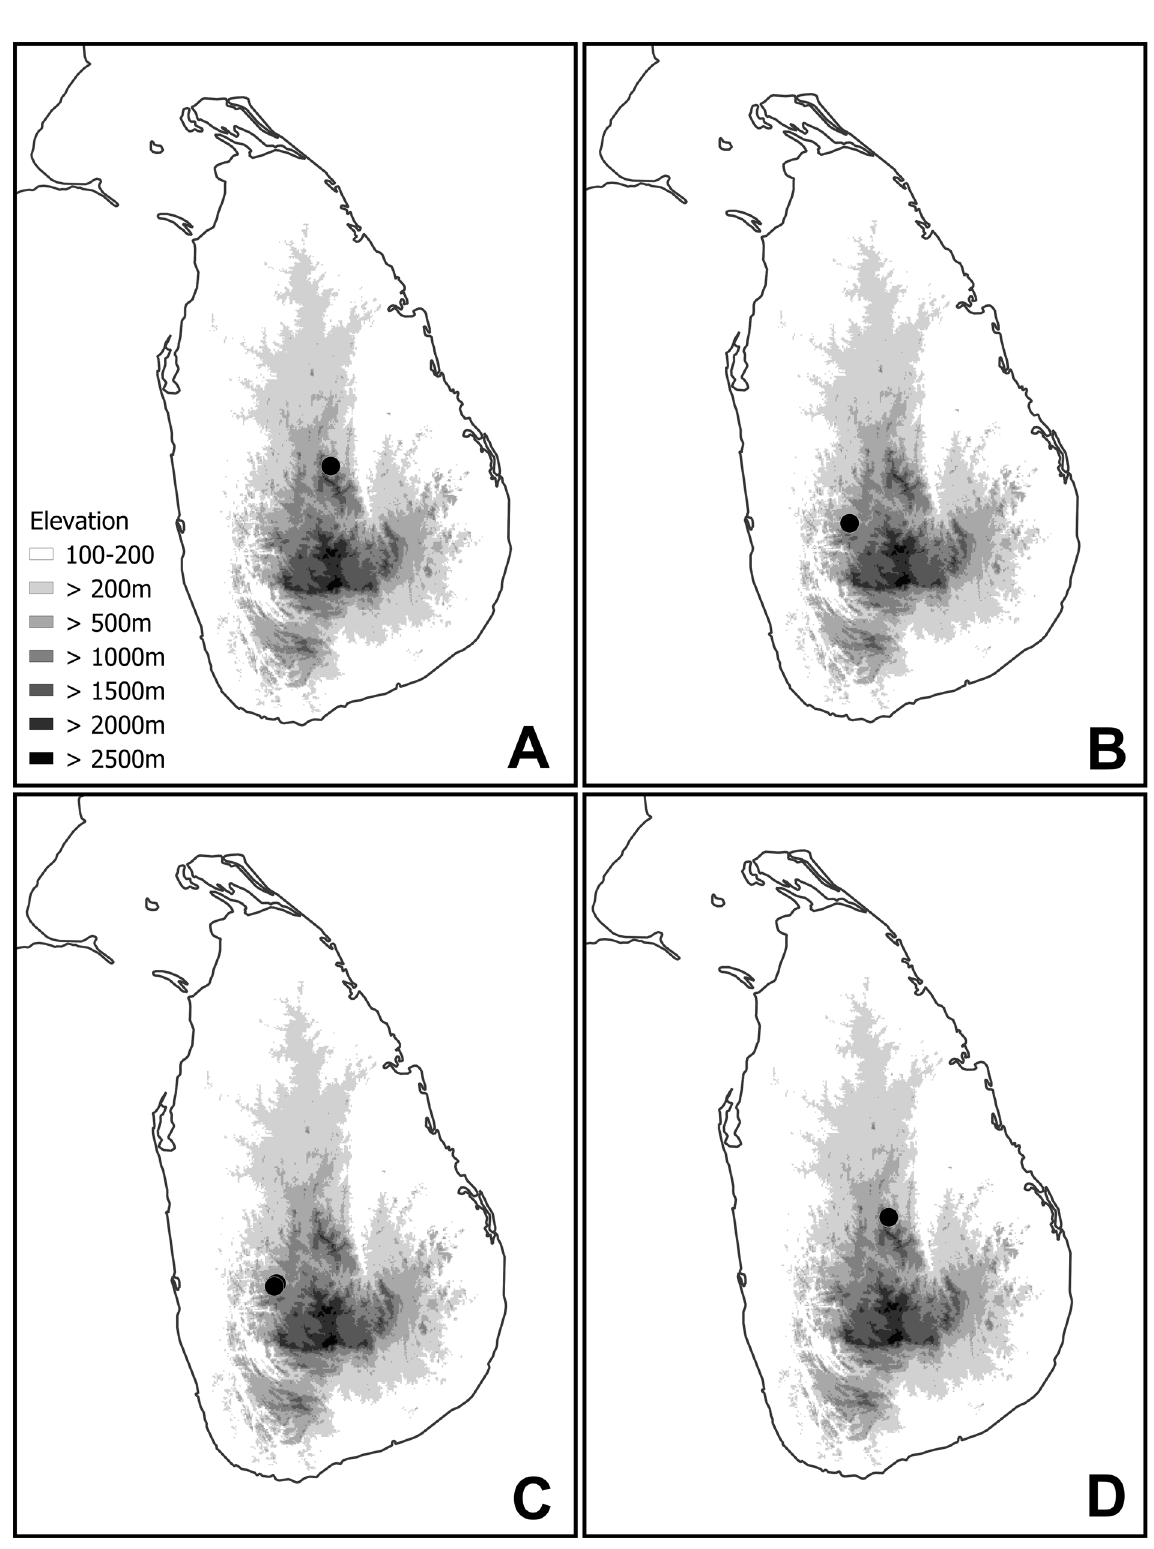
Fig. 5. Distribution of the new species. A . Selaserica athukoralai sp. nov. B . Neoserica